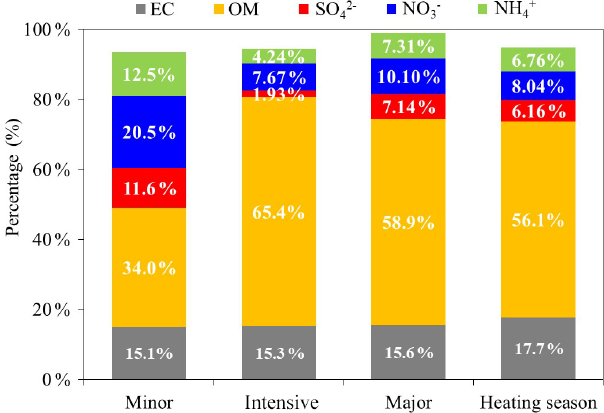
Figure 6. Mean percentiles of major components in PM 2 . 5 with respect to different biomass burning pollution periods at the GC site during the sampling